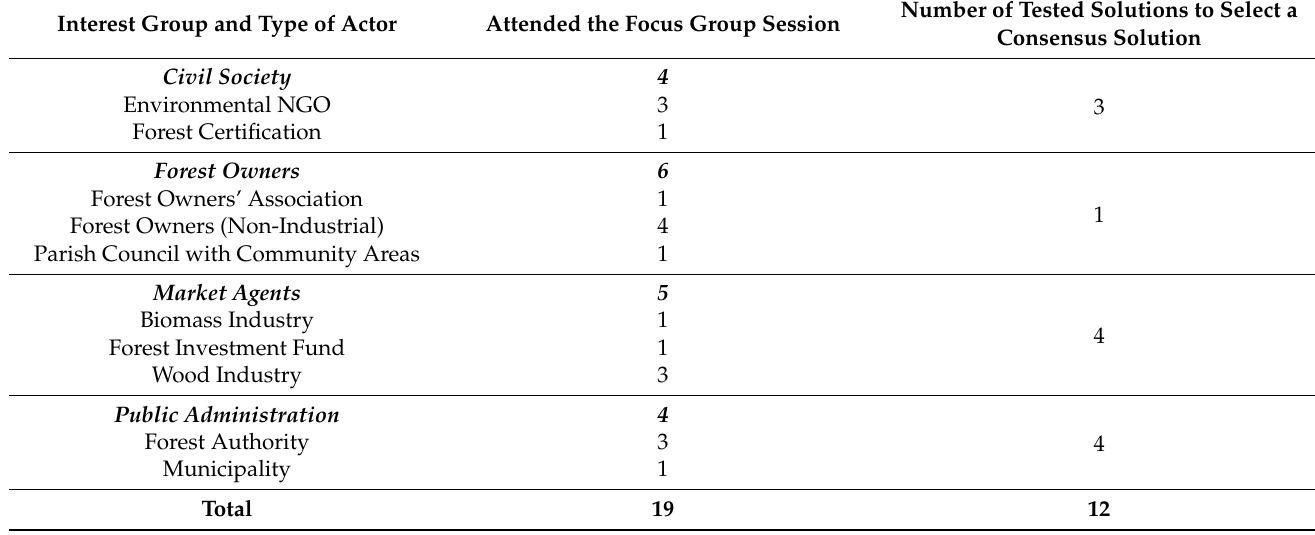
Table 2. Identification of the actors who attended the focus group session and number of iterations to reach a consensus solution by interest group.